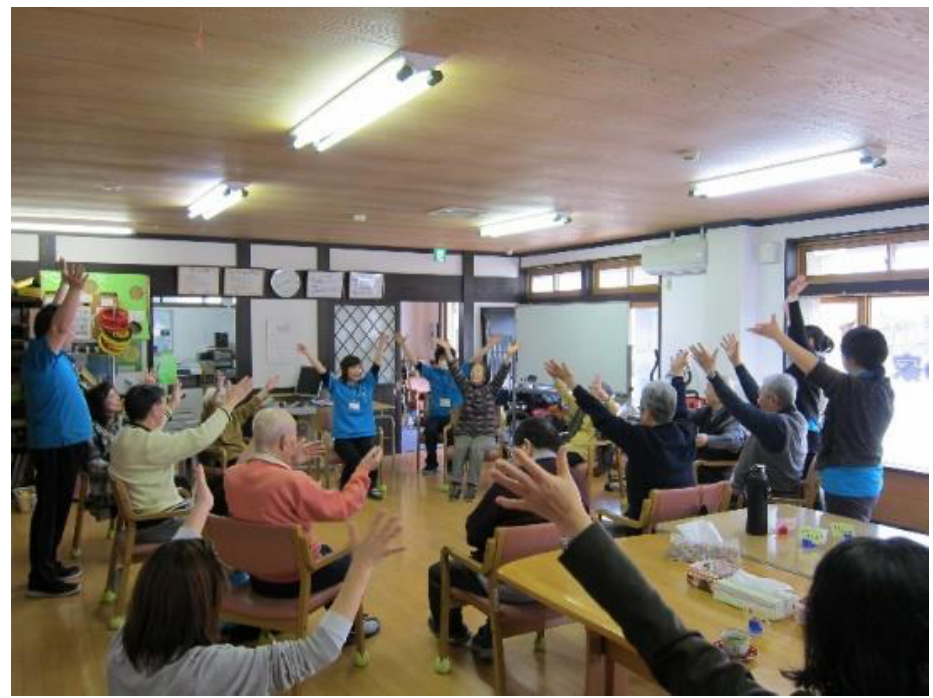
Figure 1: Older adults and staff enjoying exercises and games at a day service (Akita, Japan, March 2016. Photo courtesy of